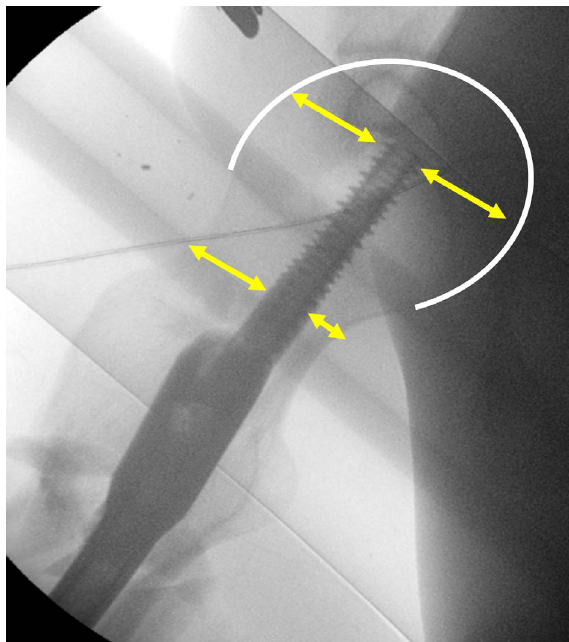
Figure 3. Image is a lateral femur X-ray with a cephalomedullary nail situated after an entry point in line with the femur neck axis resulting in an eccentric neck position. The yellow arrows illustrate disproportionate neck width on either side of the lag screw and equidistance in the femur head.